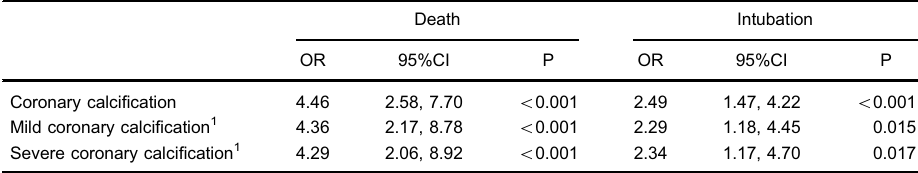
Table 2. Sensitivity analysis of the association between coronary calci fi cation and death or mechanical ventilation due to respiratory failure adjusted by age among RT-PCR-positive Covid-19